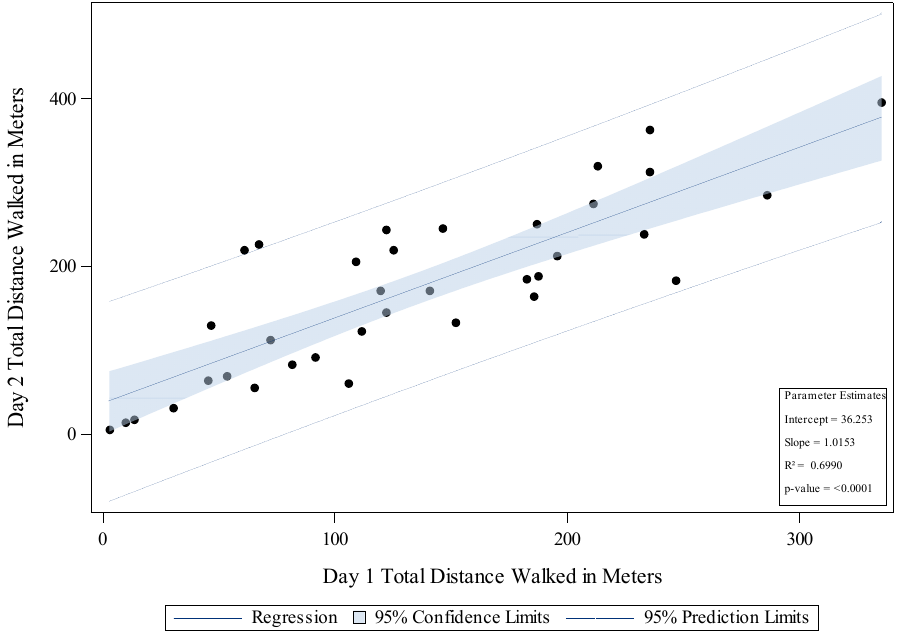
Figure 2. Mean six ‐ minute walk test (6MWT) distance on Day 1 correlated with 6MWT distance on Figure 2. Mean six-minute walk test (6MWT) distance on Day 1 correlated with 6MWT distance on Day 2. J. Clin. Med. 2017 , 6 , 84 Day 2.